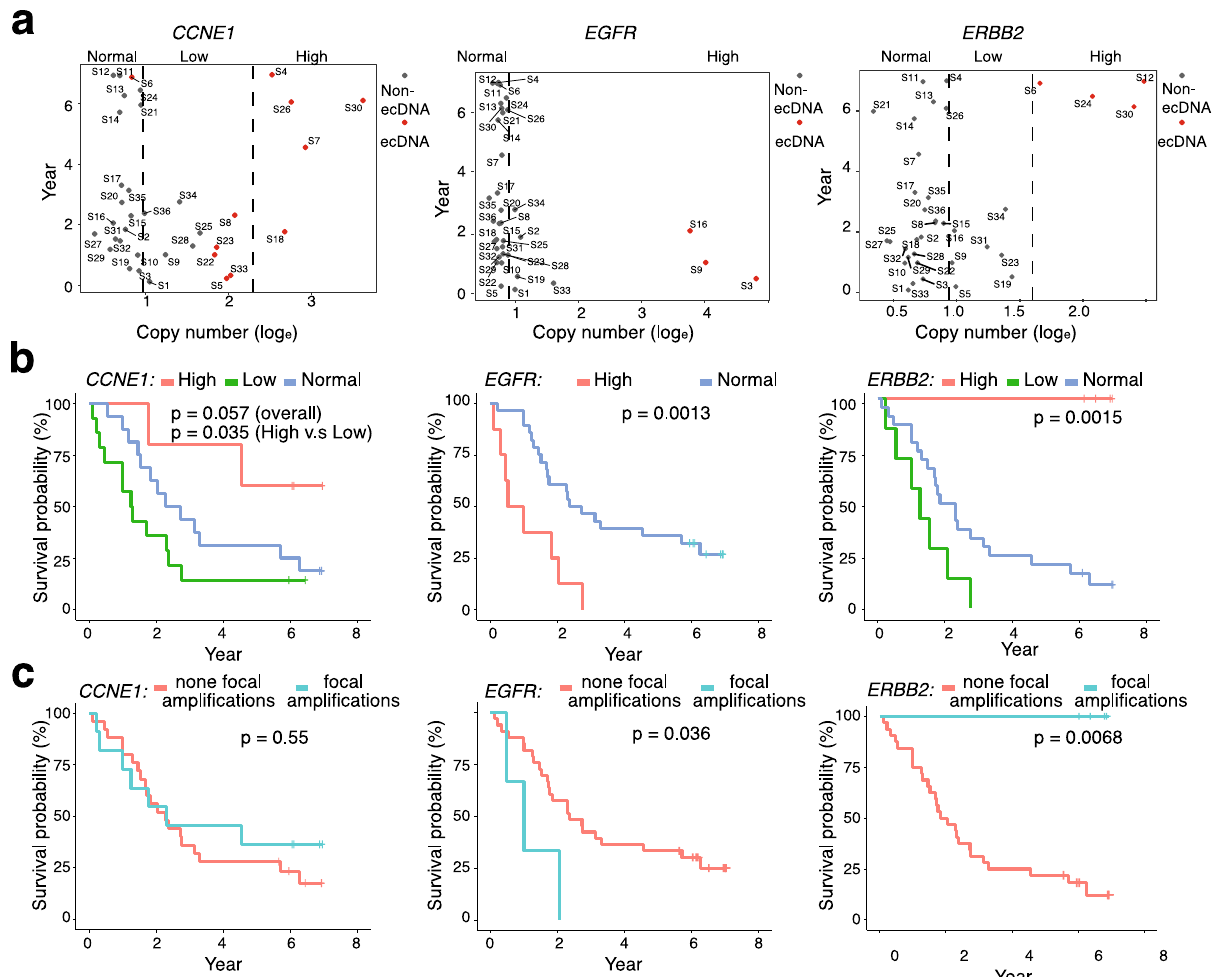
Fig. 4 Oncogene ampli fi cation, focal ampli fi cations presence and prognosis of GCA patients. a The relationship between gene copy number and survival time for CCNE1 , EGFR , and ERBB2 genes in the GCA cohort, where copy number of CCNE1 and ERBB2 genes were divided into three groups, high, low, and normal, and copy number of the EGFR gene was divided into two groups, high and normal. High high copy number of gene ampli fi cation, Low low copy number of gene ampli fi cation, Normal no gene ampli fi cation. b Survival analysis of different groups with three oncogene ampli fi cations ( CCNE1 , EGFR , and ERBB2 ) in the cohort. The de fi nition of high, low, and normal is the same as in a , and the p -value was calculated using the two-sided Log rank test. c Survival time of present and absent focal ampli fi cations of three oncogenes in ecDNA ( CCNE1 , EGFR , and ERBB2 ) in the cohort. The p -value was calculated using the two-sided Log rank test. Source data are provided as a Source Data fi le for Fig. 4a –